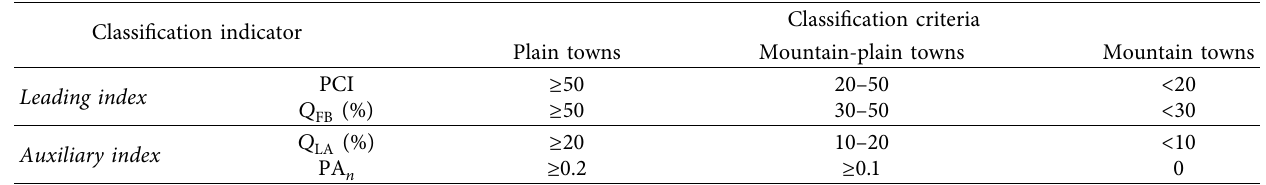
Table 2: Division criteria of plain areas and mountainous areas. Classification indicator